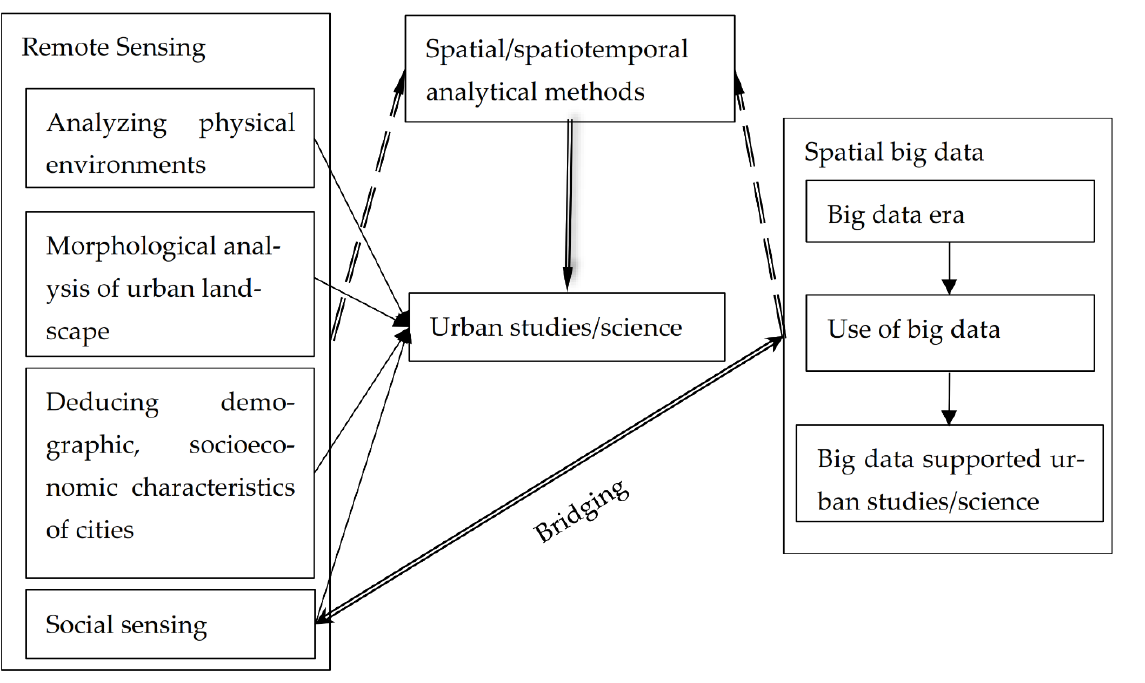
Figure 2. Flowcharts of remote sensing, spatial big data, and analytical methods supported urban studies/science.